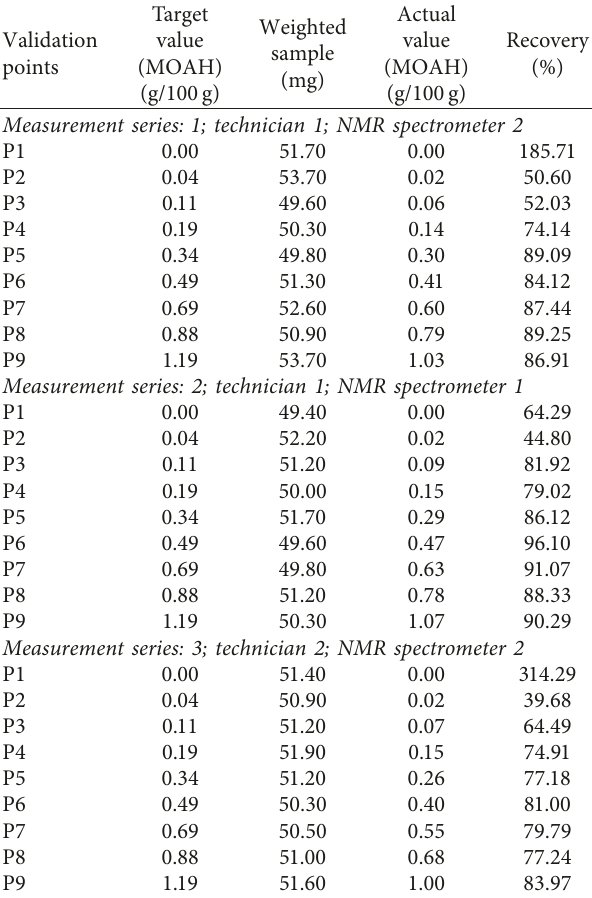
Table 8: Validation lip gloss.